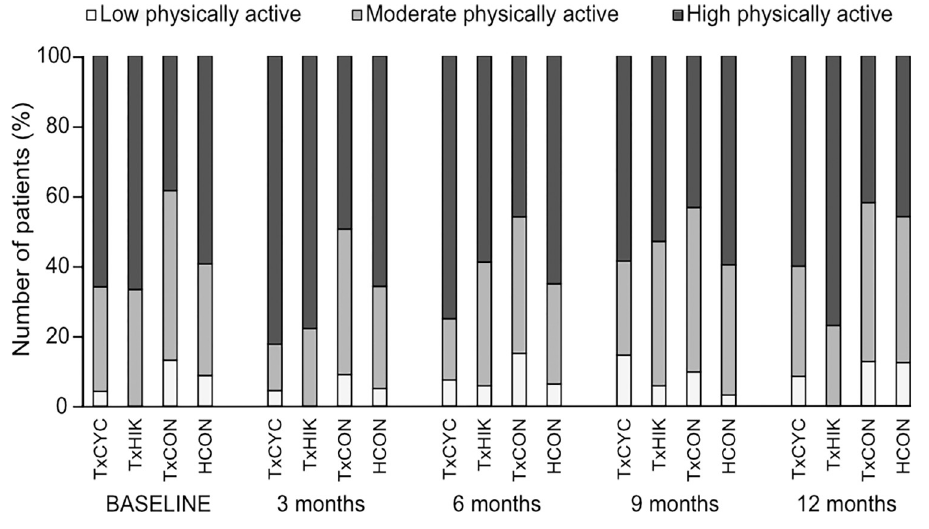
Fig 5. Physical activity status (categorical score) for all groups at each time